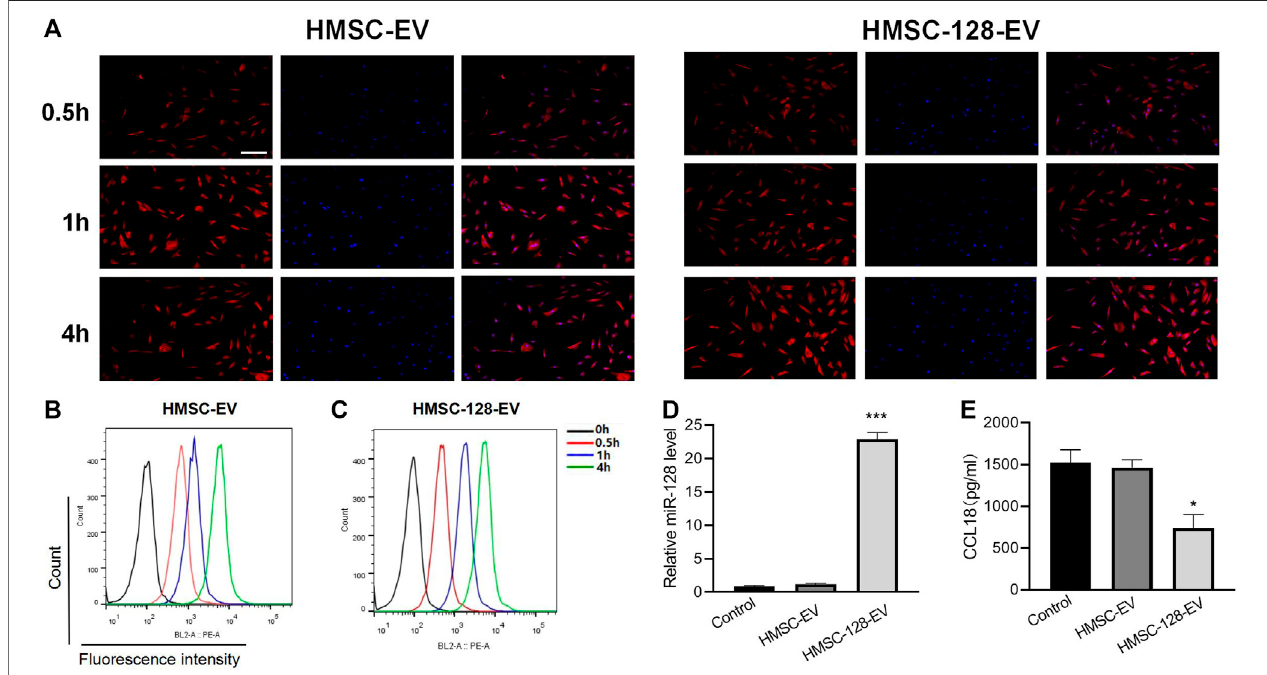
FIGURE 4 | HMSC-128-EV is able to signi fi cantly increase miR-128 within BUC T24 while reducing CCL18 expression. (A – C) are the results of endocytosis of exosomesdetectedbyconfocalmicroscopyand fl owcytometry,andbothHMSC-EVandHMSC-128-EVcouldbeendocytosedbyBUCT24. (D) isthelevelofmiR-128 within BUC T24 of each group as determined by RT-PCR, and HMSC-128-EV was able to signi fi cantly increase intracellular miR-128. (E) is CCL18 within BUC T24 of each groupdeterminedbyELISA,andHMSC-128-EVwasabletoinhibitCCL18expressionwithinthecells.* p < 0.05,*** p < 0.001vs.Control.Scalebars:30 μ m.